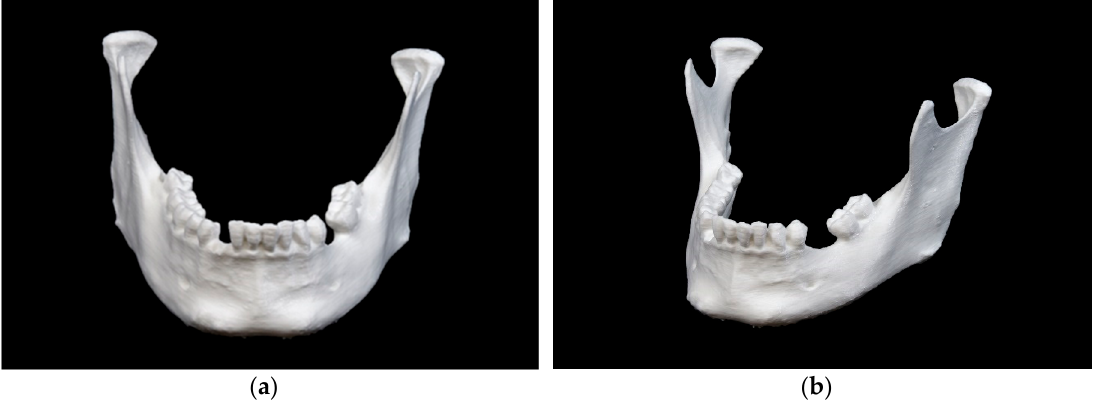
Figure 3. Mandibular model printed in fused filament fabrication (FFF) technology: ( a ) front view; ( b ) side view.